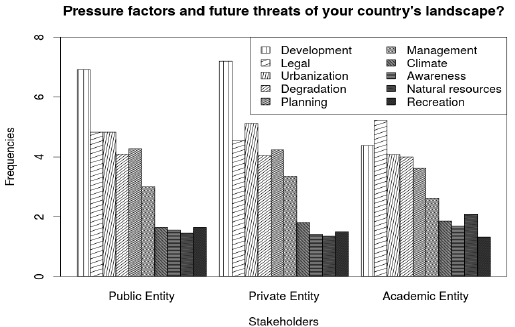
Figure 8. Frequencies of answers to the question “What do you consider to be the pressure factors and future threats of your country’s landscape?” by stakeholder type.